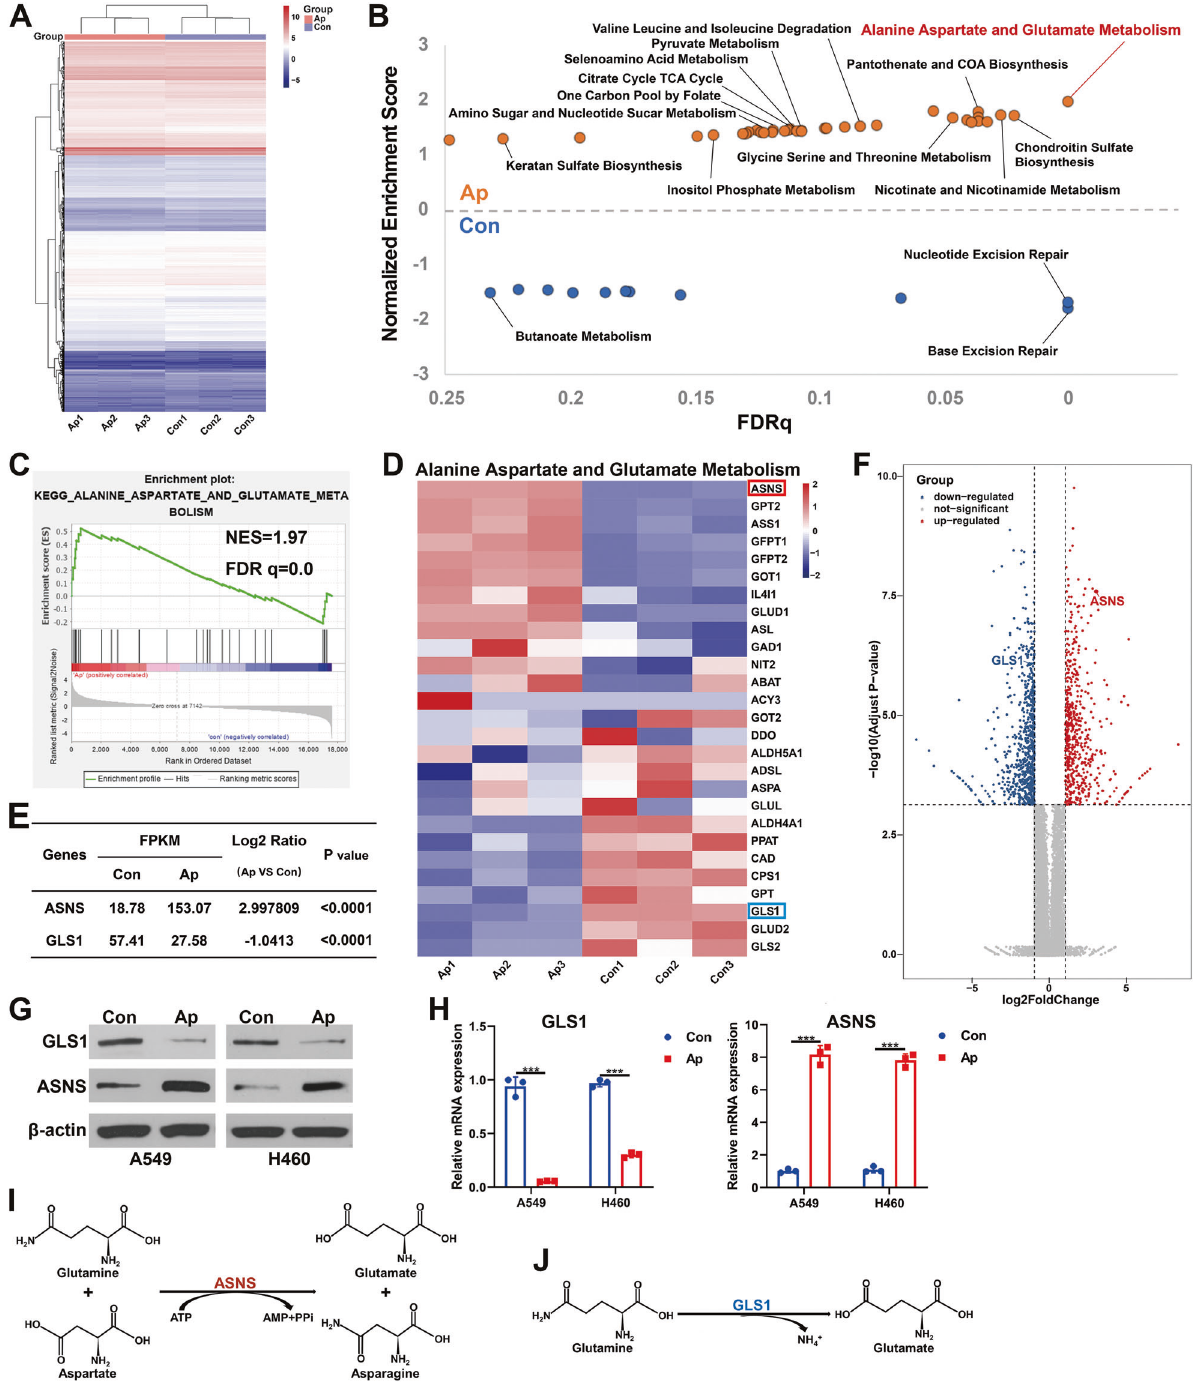
Fig. 3 Apatinib activated alanine, aspartate and glutamate metabolism in NSCLC cells. A Hierarchical clustering (heatmap) of the differentially expressed genes (DEGs) of A459 cells with or without apatinib treatment (20 μ M, 48 h). B Gene set enrichment analysis (GSEA) of metabolism-related genes in the A549 cells of both groups. The X -axis represents the FDR statistical value (FDRq), and the Y -axis represents the normalized enrichment score (NES). C GSEA of alanine, aspartate, and glutamate metabolism-related genes. NES, normalized enrichment score; FDRq, FDR statistical value. D Heatmap of the relative mRNA expression of alanine, aspartate, and glutamate metabolism-related genes. E mRNA expression of ASNS and GLS1 from the RNA-seq data. F Volcano plot of the DEGs. GLS1 and ASNS were marked up. The X -axis and the Y -axis represents log2 (fold change) and − log10 (adjusted p value), respectively. G Protein and H mRNA expression levels of GLS1 and ASNS detected by WB and qRT – PCR in A549 and H460 cells with apatinib (20 μ M, 48 h) or negative control treatment. I Reaction catalyzed by ASNS. J Reaction catalyzed by GLS1. Data are presented as mean ± SEM from three independent experiments.